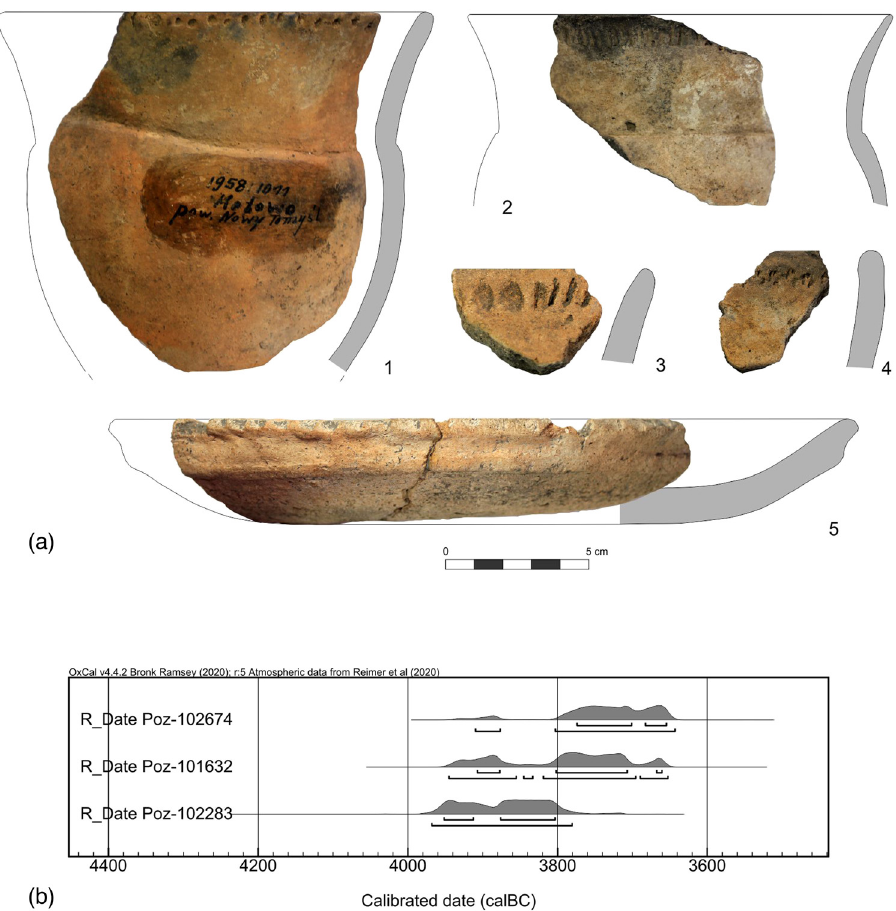
Figure 3: Kotowo, site 1 Grodzisk district, Feature 1. ( a ) Selection of FBC early phase pottery; ( b ) calibration results of radio - carbon dates for Feature 1 in OxCal v4.3.2 ( after Ż urkiewicz, 2020; Reimer et al., 2020 )